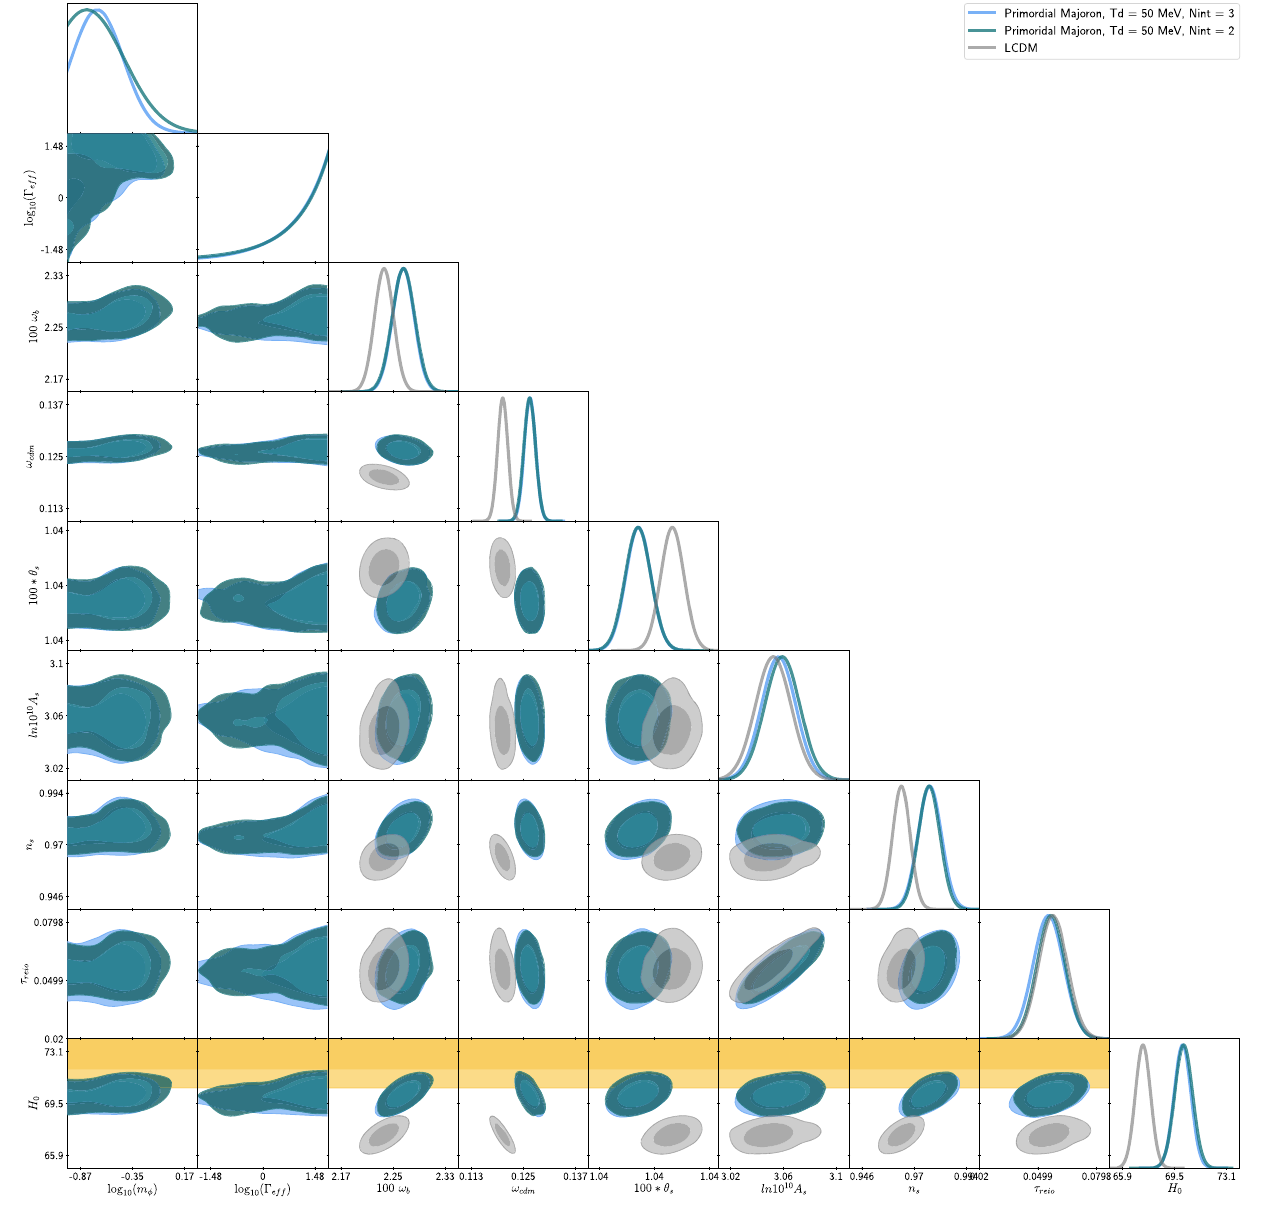
Fig. 11 Posterior probabilities from an MCMC using Planck2018+BAO data, comparing the results of (cid:3) CDM to the leptogenesis-inspired majoron model with a decoupling temperature T d = 50 MeV and N int = 2 (purple), or N int = 3 (blue). Results for N int = 1 are comparable, and are not shown for